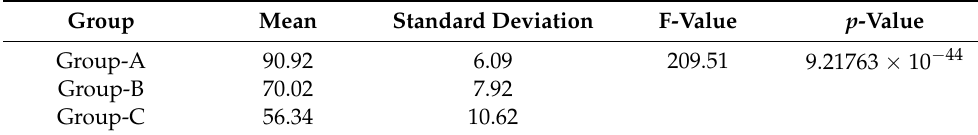
Table 4. One-way ANOVA tests result for learning achievements during different activities.